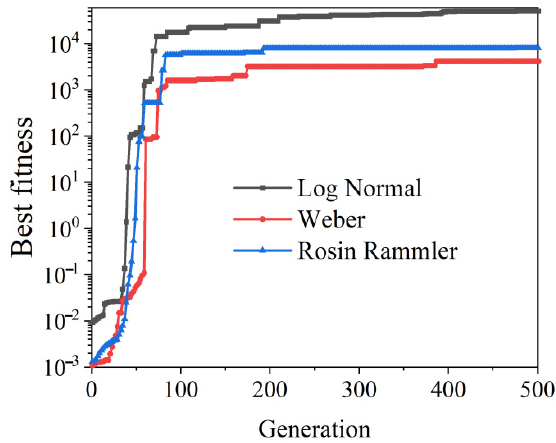
Figure A1. The variation of best fitness for different distribution functions.